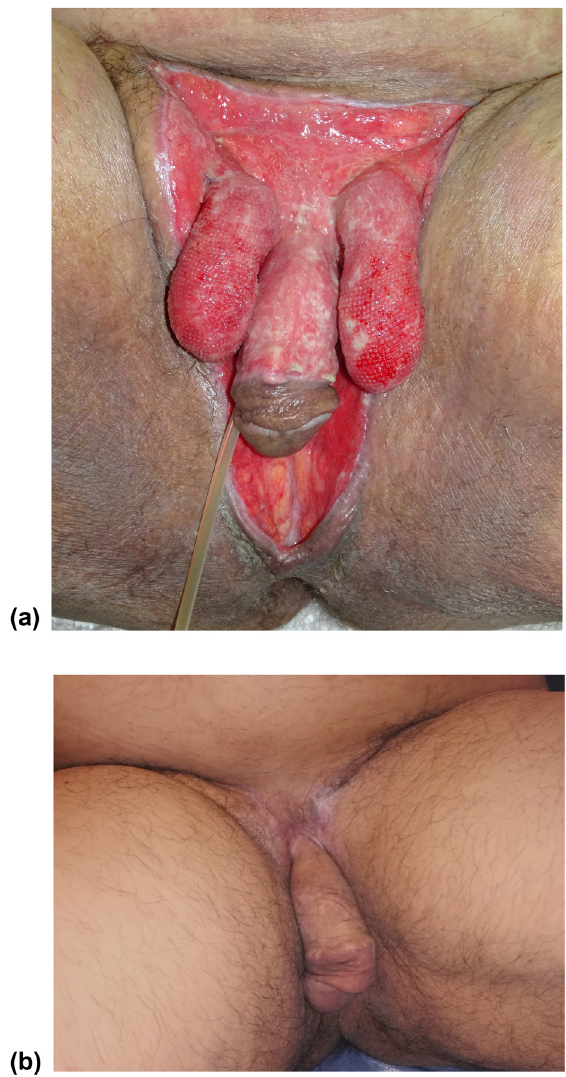
Figure 5: ( a ) A 64 - year - old patient with diabetes mellitus. An important loss of substance of the pubic/perineal area, with the removal of the whole scrotum and the skin around the penis. ( b ) Placement of the testicles in the inner face of the thighs and skin fl aps from the inner face of the thighs to close the median rafe. Graft of the skin around the penis from the inner face of the arm. The sliding fl ap of the abdominal skin to repair the